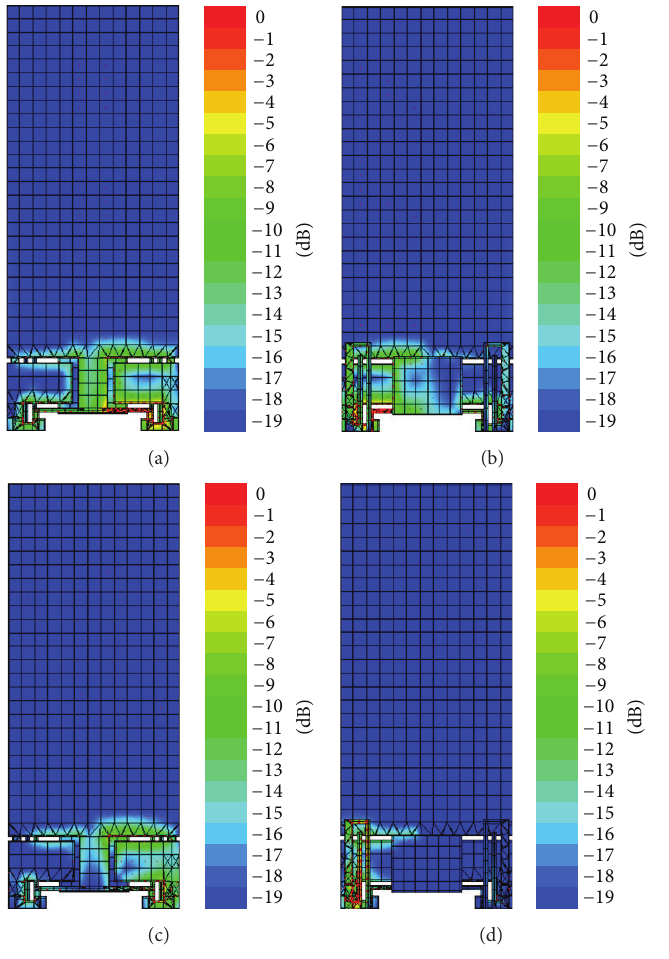
Figure 10: (a) Front view of surface current distributions at 780 MHz when Port 2 is excited. (b) Back view of surface current distributions at 780 MHz when Port 2 is excited. (c) Front view of surface current distributions at 2.350 GHz when Port 2 is excited. (d) Back view of surface current distributions at 2.350 GHz when Port 2 is excited.